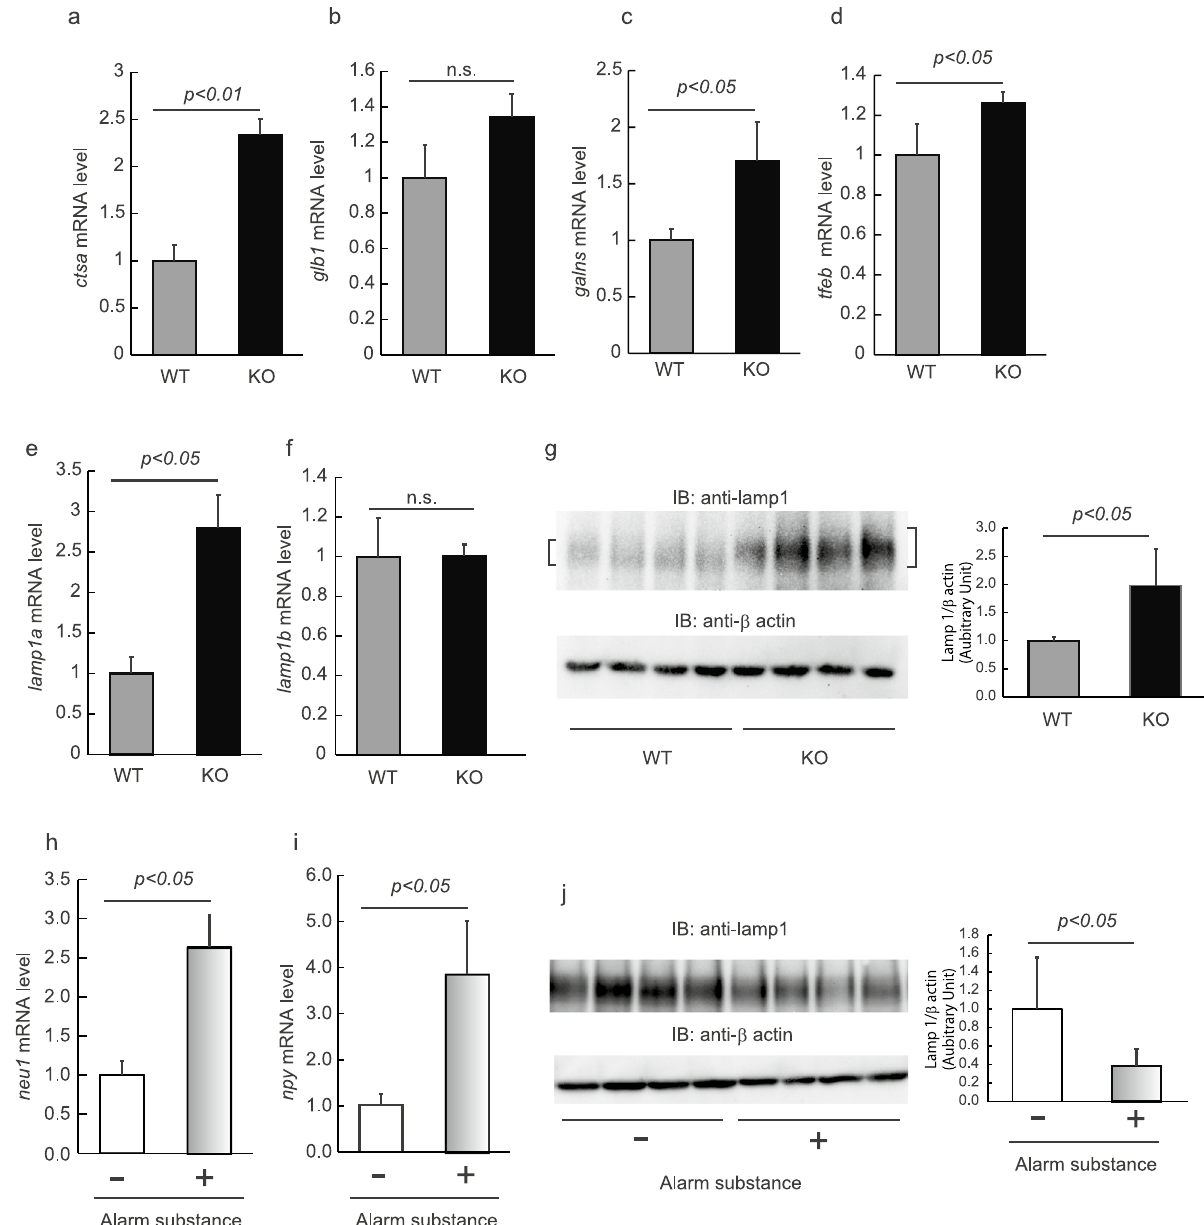
Figure 8. Changes in the expression of lysosomal genes in Neu1-KO zebrafish. mRNA levels of ctsa ( a ), glb1 ( b ), galns ( c ), tfeb ( d ), lamp1a ( e ), and lamp1b ( f ) in WT and Neu1-KO zebrafish. Each level of gene expression in Neu1-KO zebrafish is relative to the value in WT fish. n = 7 for each group. ( g ) Lysates of zebrafish brains were applied for western blotting using anti-lamp1 and anti-β actin antibodies. Quantitative analyses of the intensities of Lamp1 and β-actin bands were carried out and results are presented as Lamp1/β-actin. ( h – j ) WT zebrafish were exposed to alarm substances and then the neu1 ( h ) and npy mRNA levels ( i ) were estimated by real-time PCR. Lysates of zebrafish brains were applied for western blotting using anti-lamp1 and anti-β actin antibodies ( j ). Quantitative analyses of the intensities of Lamp1 and β-actin bands were carried out and results are presented as Lamp1/β-actin. n = 6 for each group. Results are shown as means ± standard deviation. All values were compared using Mann–Whitney U test. n.s., not